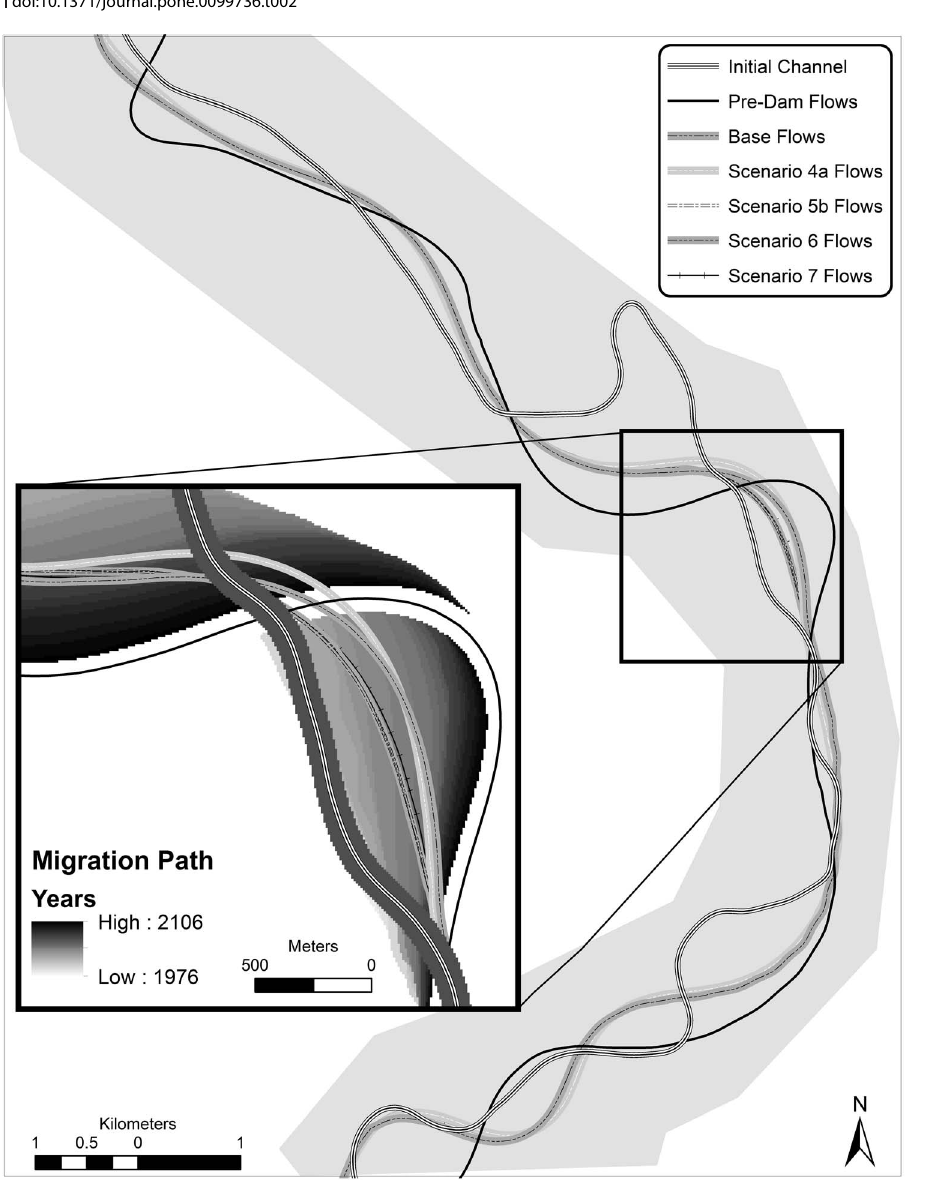
Figure 2. Meander migration model output centerlines for each scenario after 130 year simulation, including the initial channel centerline. The inset map includes a zoomed in migration path of the pre-dam flow channels. Scenarios 5b and 6 are close to overlapping.